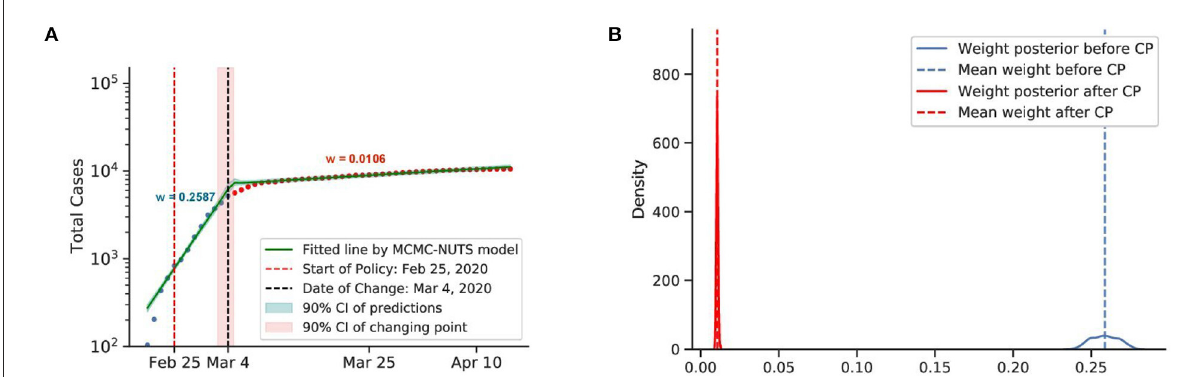
FIGURE10 Posterior for South Korea. South Korea was the second epicenter of the outbreak after the super-spreader event of Patient 31. The government relied on social distancing and extensive contact tracing to avoid a stringent lockdown, starting shortly after the Patient 31 event (around February 25, 2020) (75, 76), and brought the outbreak under control in March, with a decline in the growth rate from 0.2587 to 0.0106. The change-point point was around March 4, 2020. (A) Fitted graph for South Korea with change-point on March 4, 2020. (B) Posterior distribution of weights (transmission rate) before and after change-point.